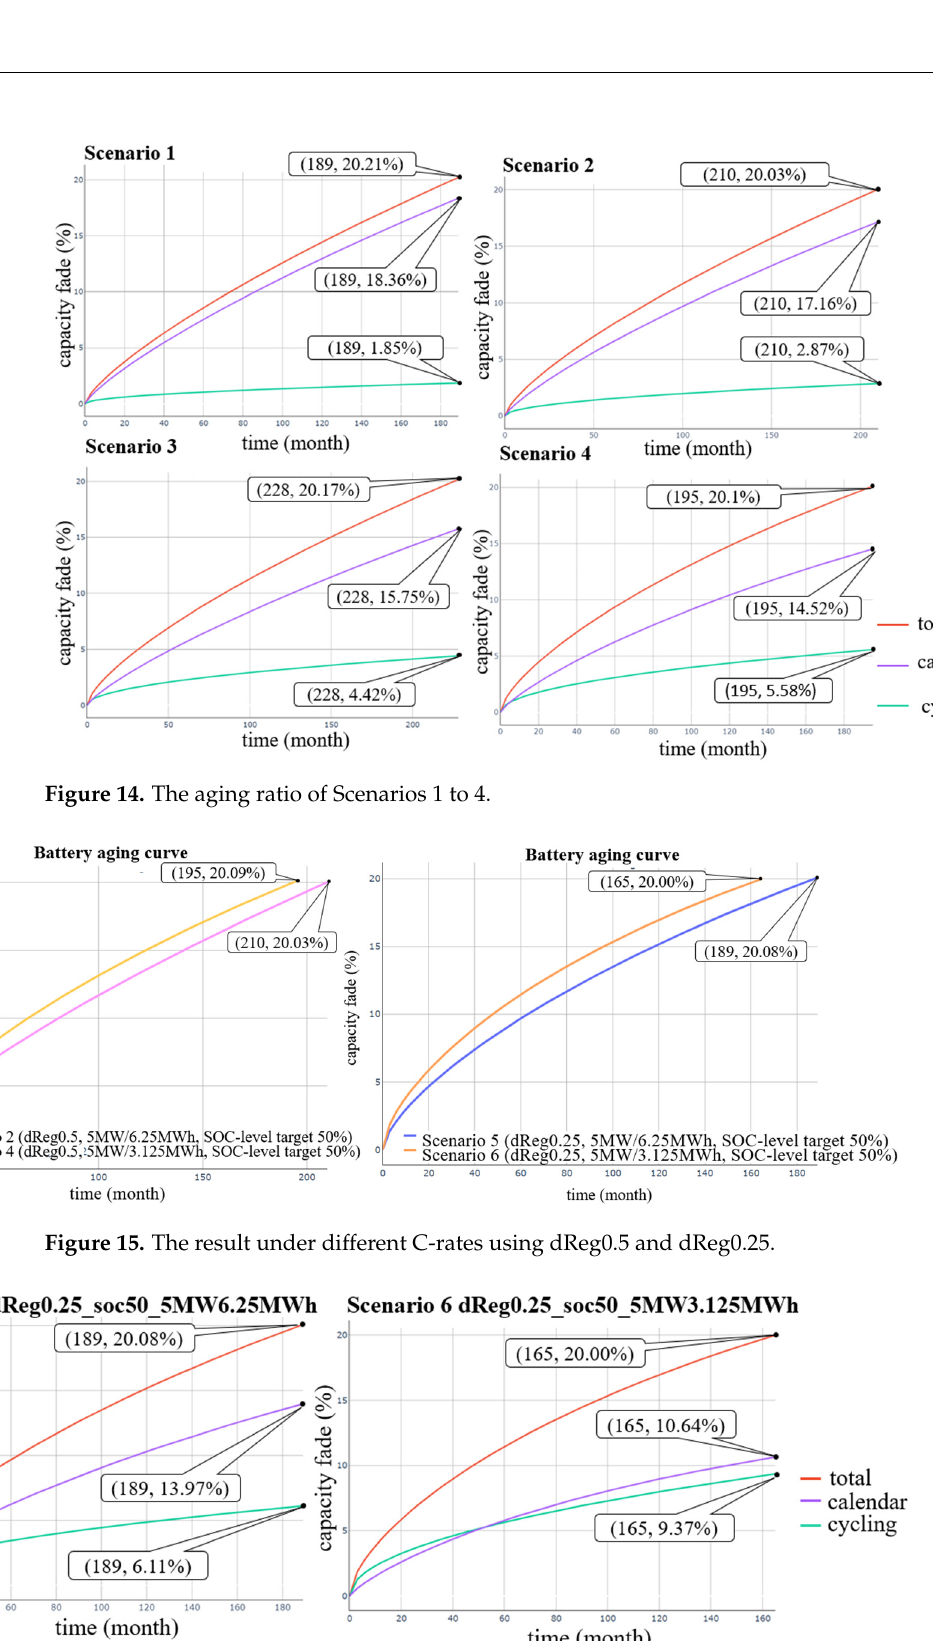
Figure 16. The aging ratio of Scenarios 5 and 6.